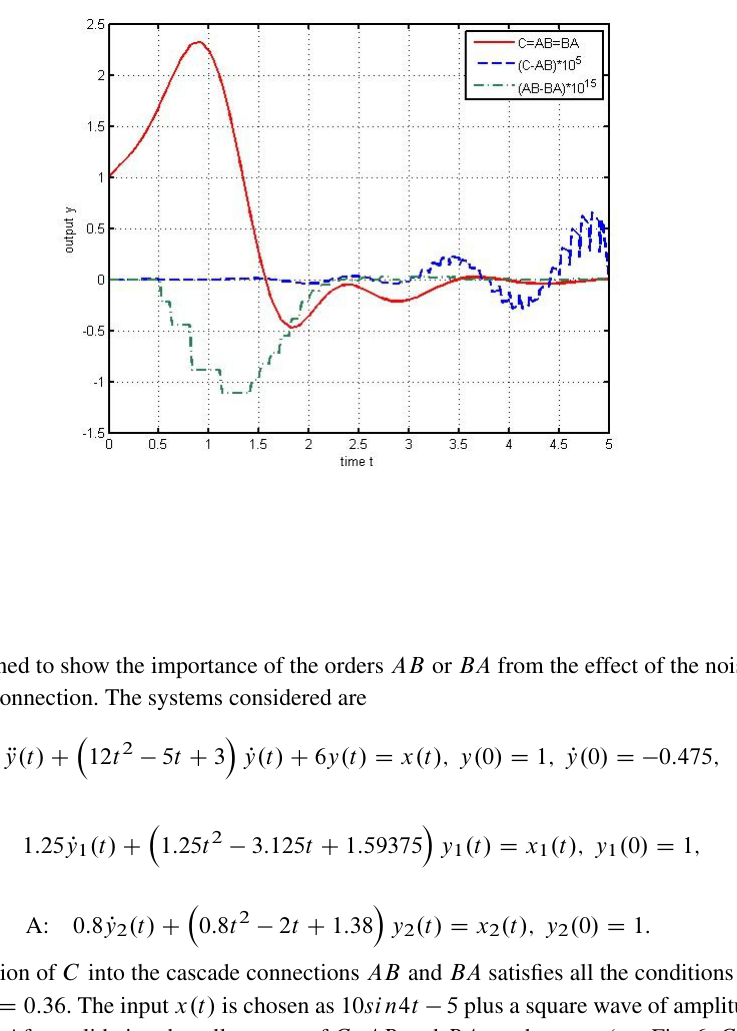
Fig. 5. The outputs and differences between the outputs of the system of Example 3 and its cascade